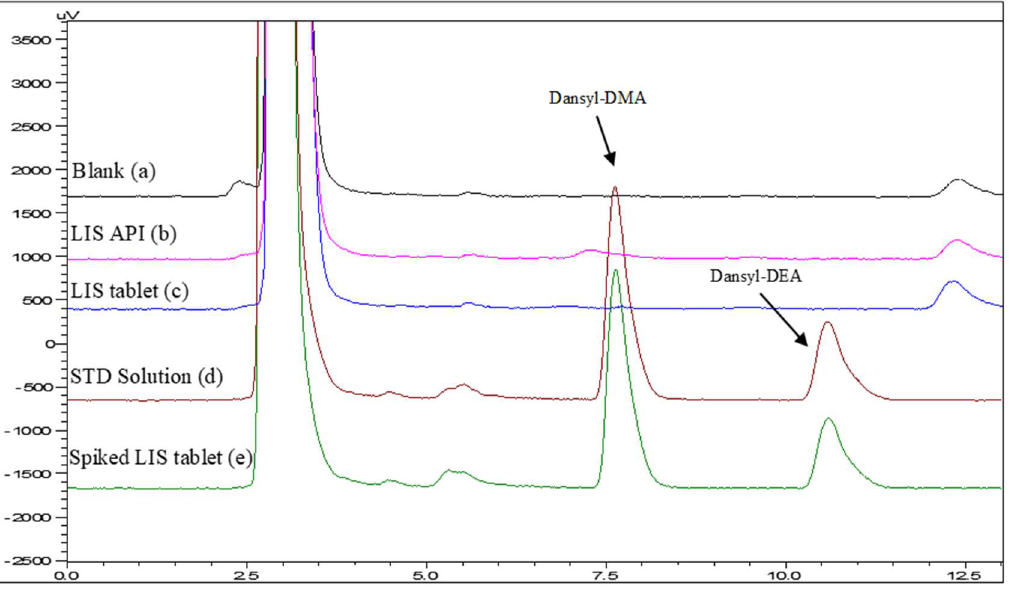
Figure 2. Representative chromatograms: (a) Blank, (b) Lisinopril API, (c) tablet formulation, (d) standard solution, and (e) spiked tablet formulation at a concentration level of 0.16 μg/mL.